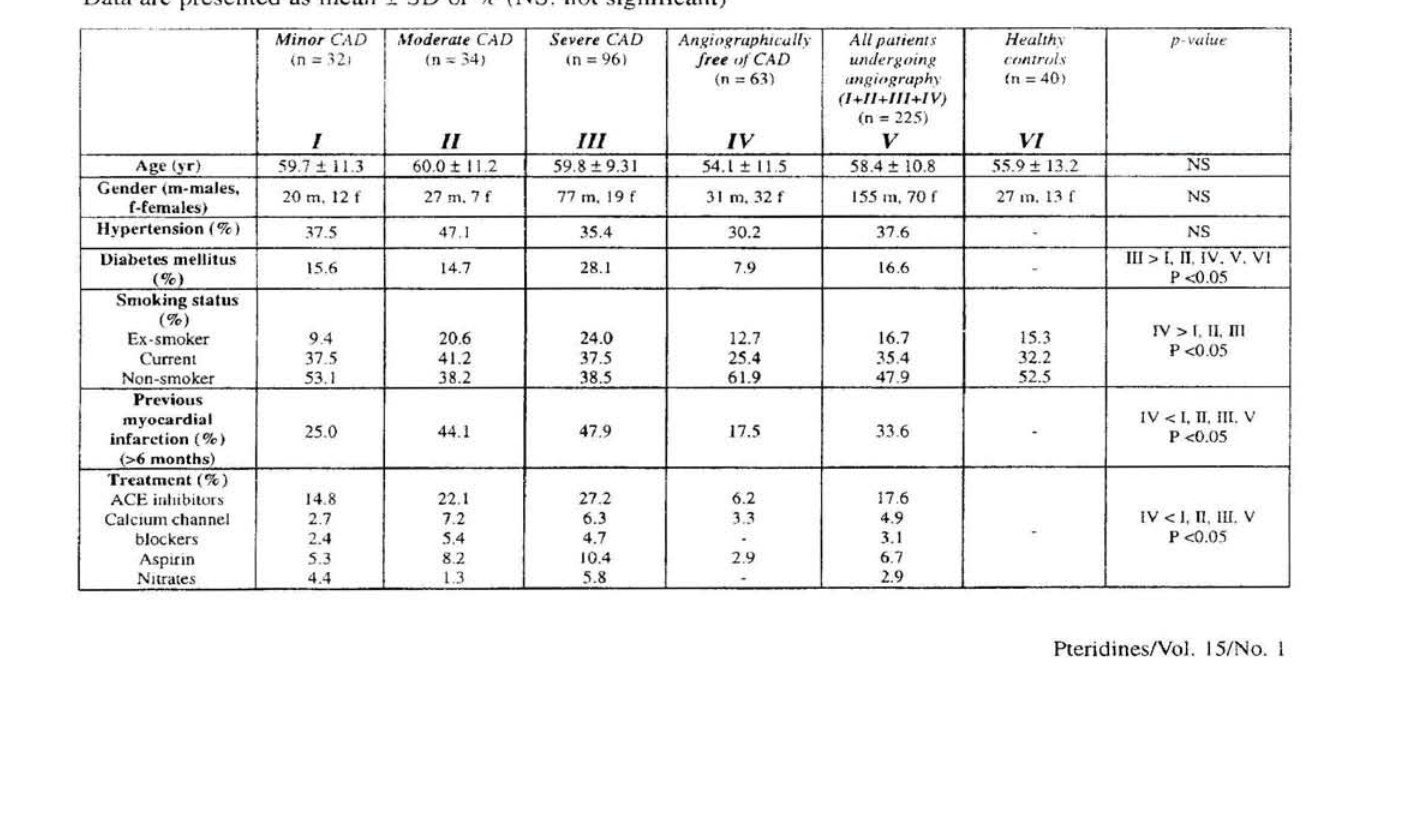
Table 1. Demographic and clinical characteristics of patients with coronary artery disease (CAD) and controls. Data are presented as mean ± SD or % (NS: not significant) Minor CAD Moderate CAD Severe